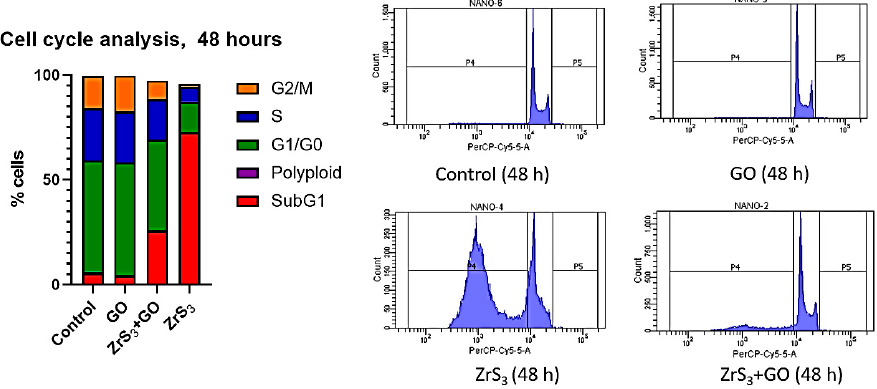
Figure 8. Cell cycle distribution of HCT116 cells on nanostructured films (control, GO, ZrS3, ZrS3+GO).